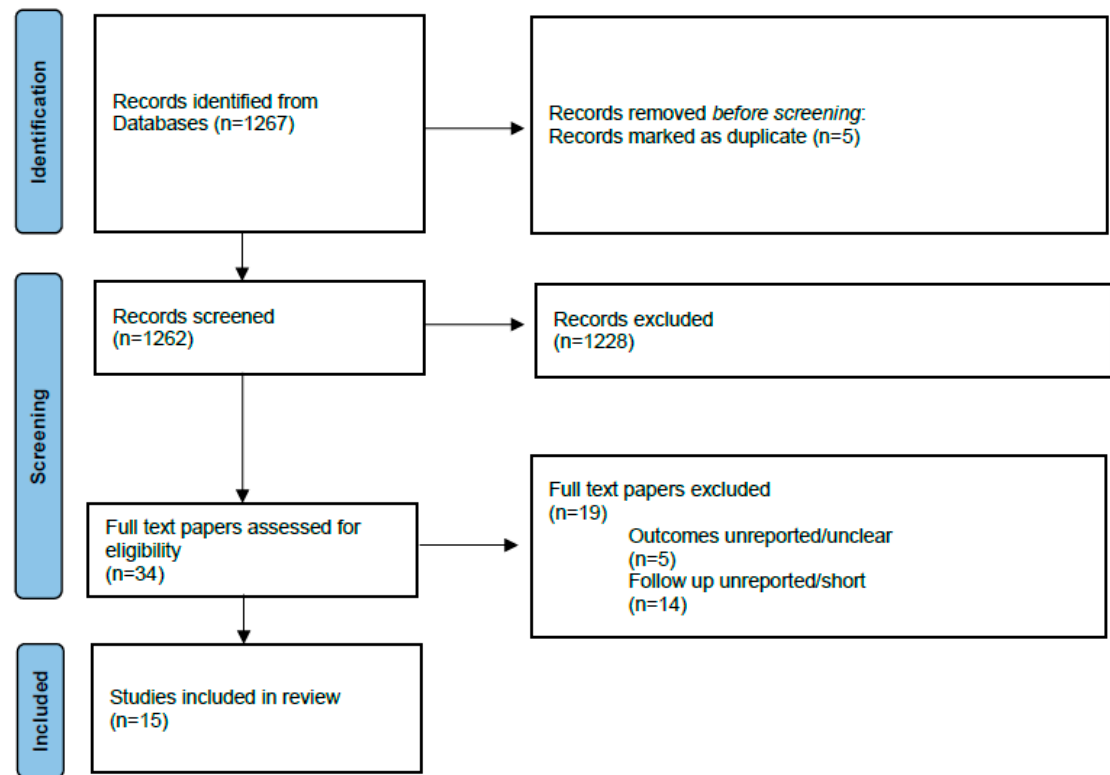
Figure 1. PRISMA flowchart of study Figure 1. PRISMA fl owchart of study selection.